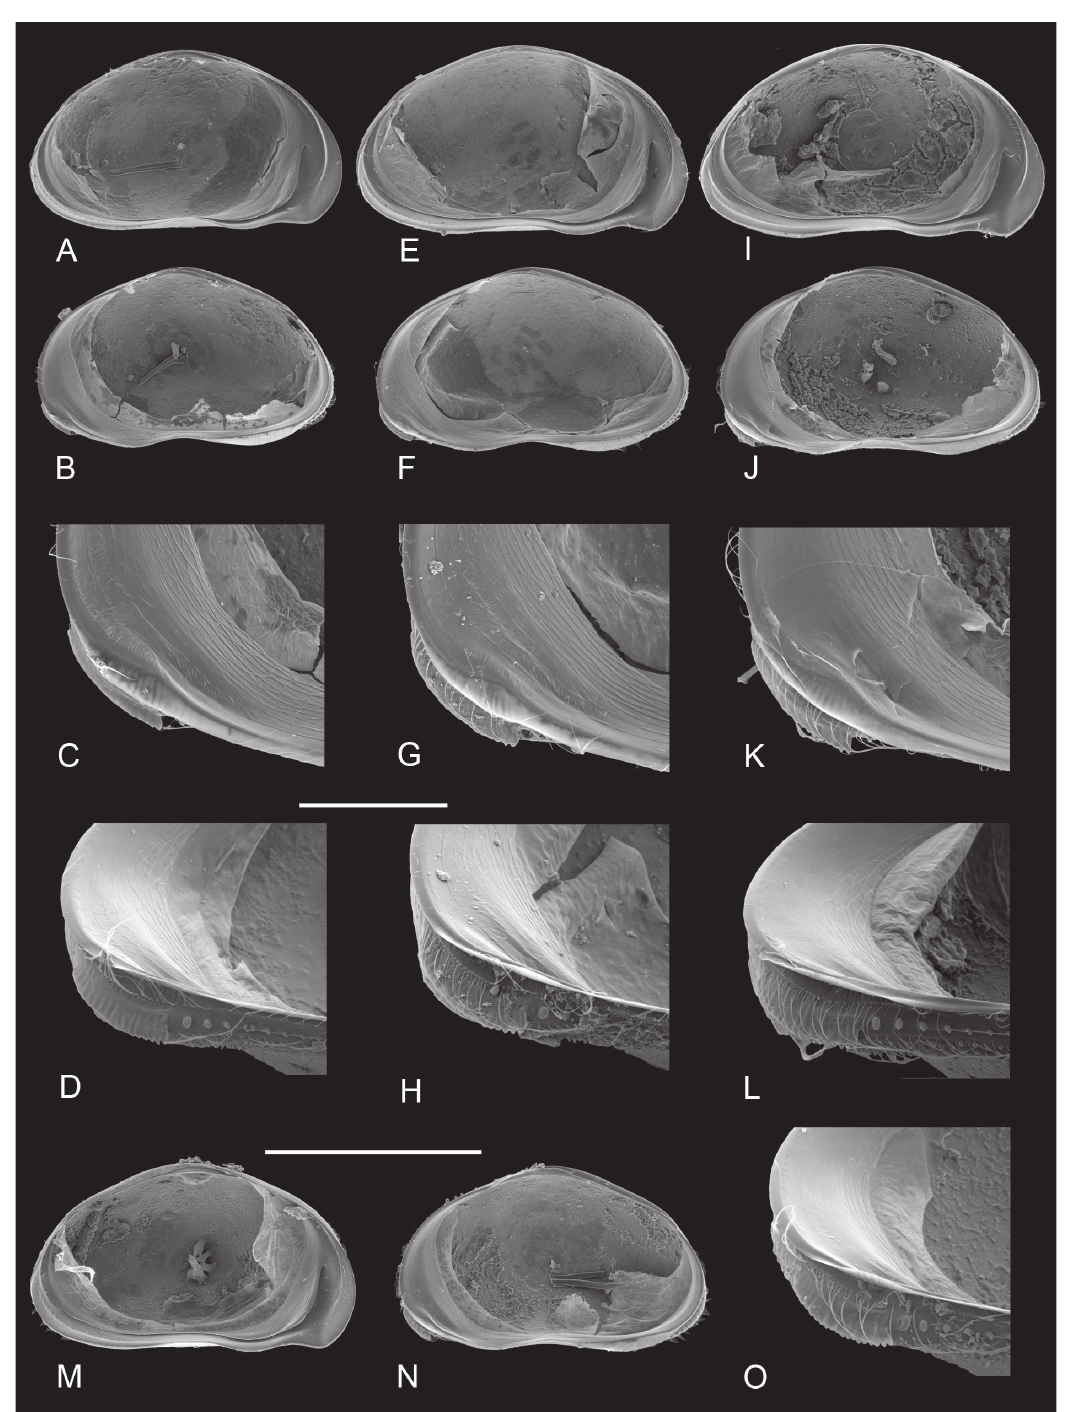
Fig. 22. Bennelongia calei sp. nov., non-type specimens. — A-D . Oak Flat W pit gnamma, via Goomalling (BVT/11/04, ♀, OC.3346). A . lVi. B . rVi. C . rVi, detail anterior. D . rVi, detail anterior, tilted. — E-H . Horse Collar gnamma, on Magee Rd via Kulin (BVT/11/05, ♀, WAMC52345). E . lVi. F . rVi. G . rVi, detail anterior. H . rVi, detail anterior, tilted. — I-L . second pool along carnamah-eneabba road on south side, Eneabba Springs (DJC/10, ♀, WAMC52349). I . lVi. J . rVi. K . rVi, detail anterior. L . rVi, detail anterior, tilted. — M-O . Pool at Jerramungup West (DJC/36, ♀, OC.3348). M . lVi. N . rVi. O . rVi, detail anterior, tilted. scales: a-B, e-F, I-J, M-n = 1 mm; c-D, G-H, K-l, O = 200